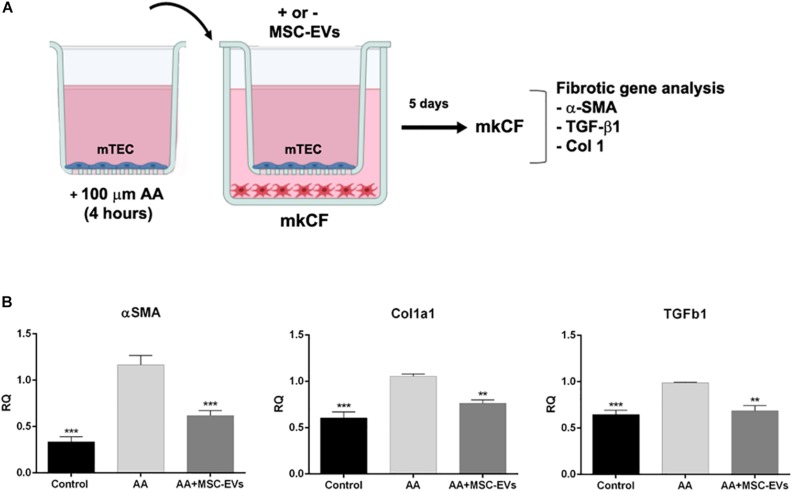
MSC-EVs downregulate pro-fibrotic genes in kidney cortical fibroblasts in an in vitro model of AAN. (A) An illustration depicting the AAN in vitro assay whereby: mTECs treated with or without AA for 4 hrs were co-cultured with mouse fibroblasts (mkCF) in the presence or absence of MSC-EVs (75,000 EVs/cell) for 5 days at 37°C. (B) Gene expression analyses revealed an upregulation of the profibrotic markers: α-Sma, Tgfb1, and Col1a1 in mkCFs co-cultured with AA treated mTECs. The expression levels of all three pro-fibrotic genes were reduced significantly following treatment with MSC-EVs. The data represents the mean ± SEM of three independent experiments performed in quadruplicate. **p < 0.01 vs. AA, ***p < 0.001 vs. AA. A one way ANOVA with Bonferroni’s multi comparison test was performed.